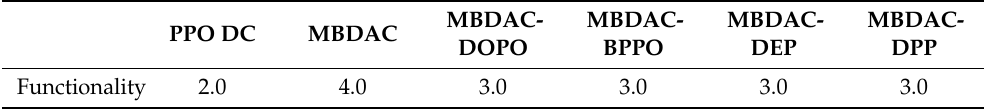
Table 6. Functionalities of carbonate monomers.